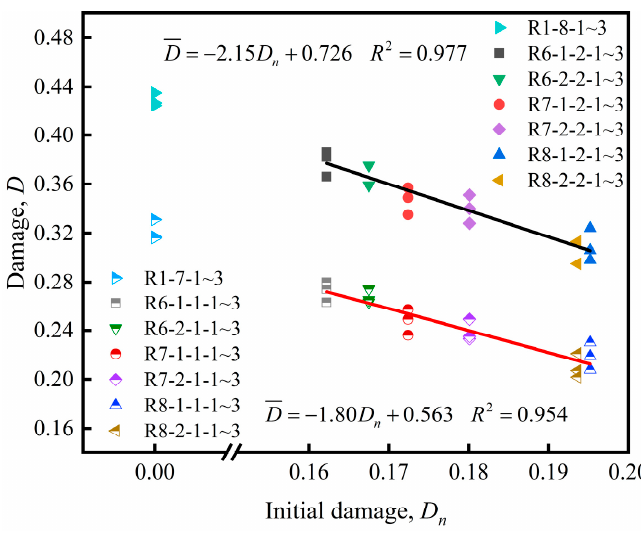
Figure 14. The damage variable of rock specimen under di ff erent initial damage in the SHPB test. Figure 14. In the SHPB test, the damage variable D of the rock specimen under different initial damage conditions: ( a ) 0.30 and ( b ) 0.35 MPa. Table 6. The dissipated energy condition of the rock specimen under a 0.30 MPa impact pressure in the SHPB